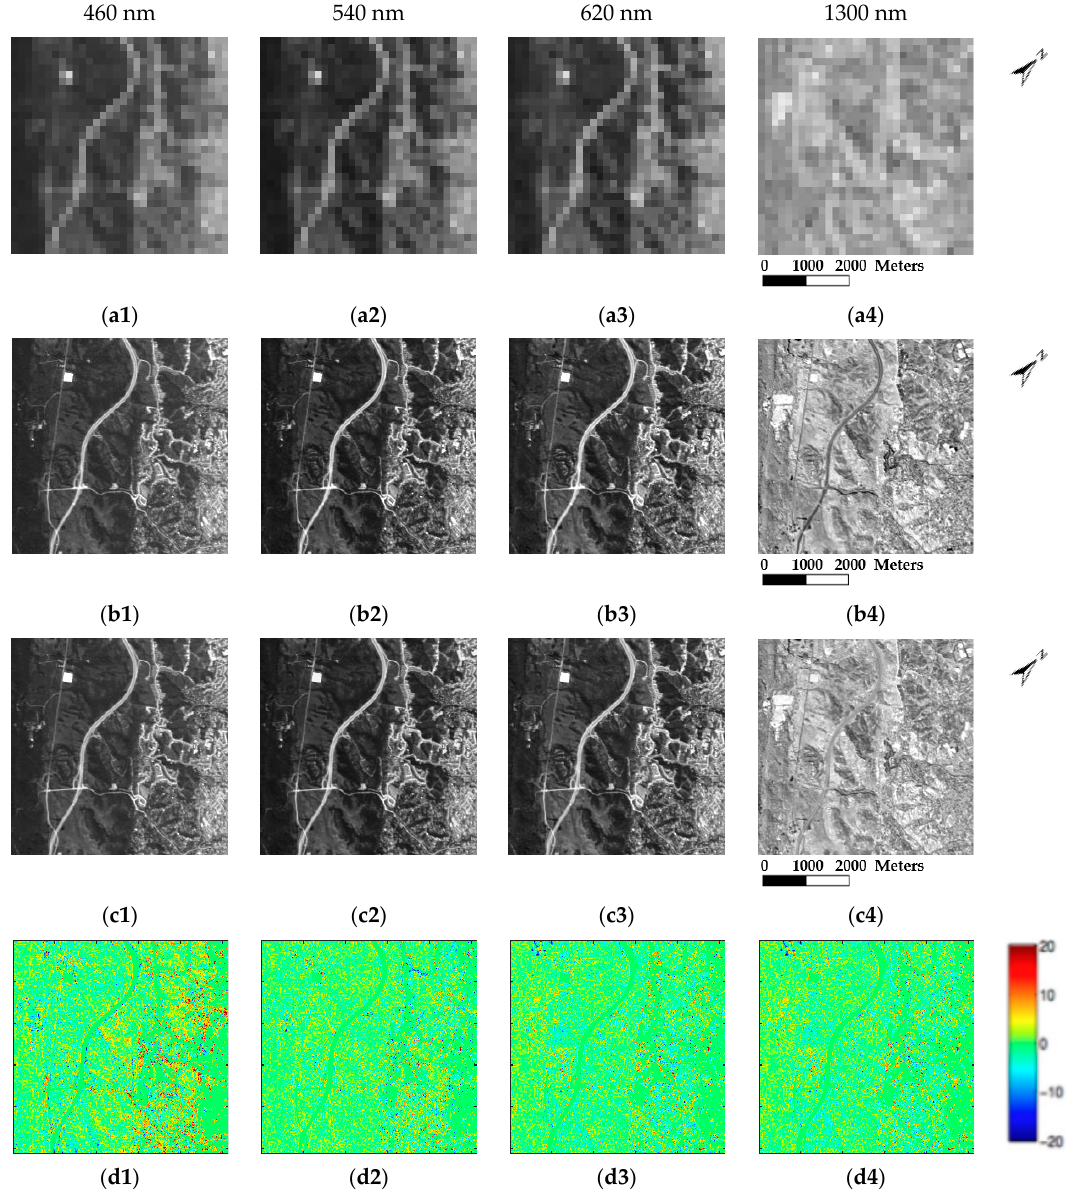
Figure 7. Fusion results of four single bands and error images of Image Jasper-Ridge: ( a1 – a4 ) LR-HSI; ( b1 – b4 ) The original HR-HSI; ( c1 – c4 ) Estimated HR-HSI; and ( d1 – d4 ) Error Image.